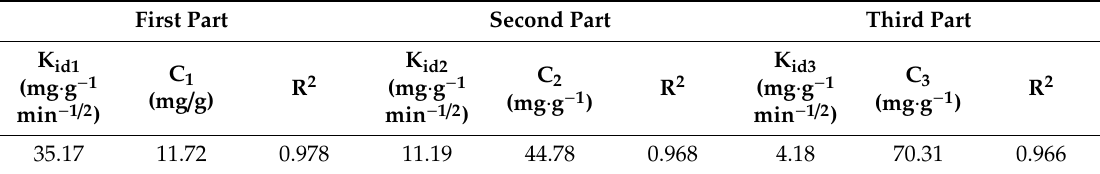
Table 2. Intra-particle di ff usion model parameters of DCF uptake onto Fe@BC. First Part Second Part